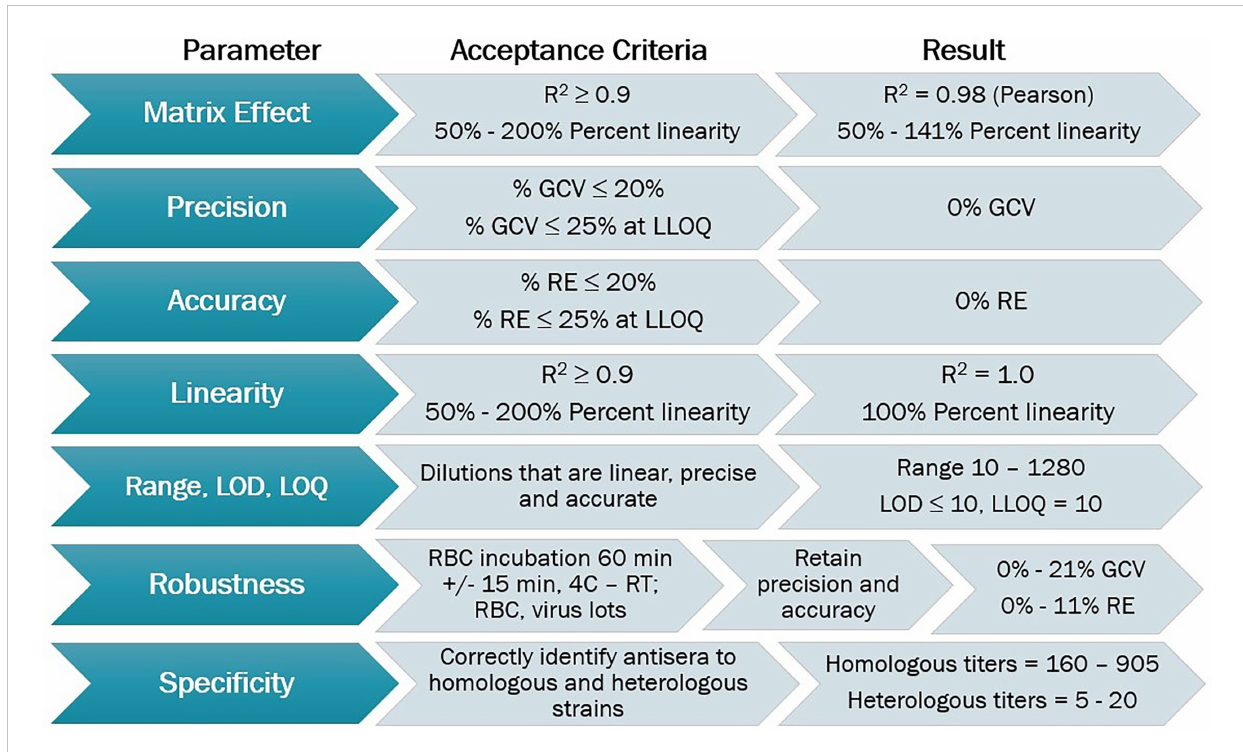
FIGURE 2 HAI assay quali fi cation for H3N2 in fl uenza strain A/Texas/71/2017, overview of quali fi cation plan and parameters tested during quali fi cation, recommended acceptance criteria, and results